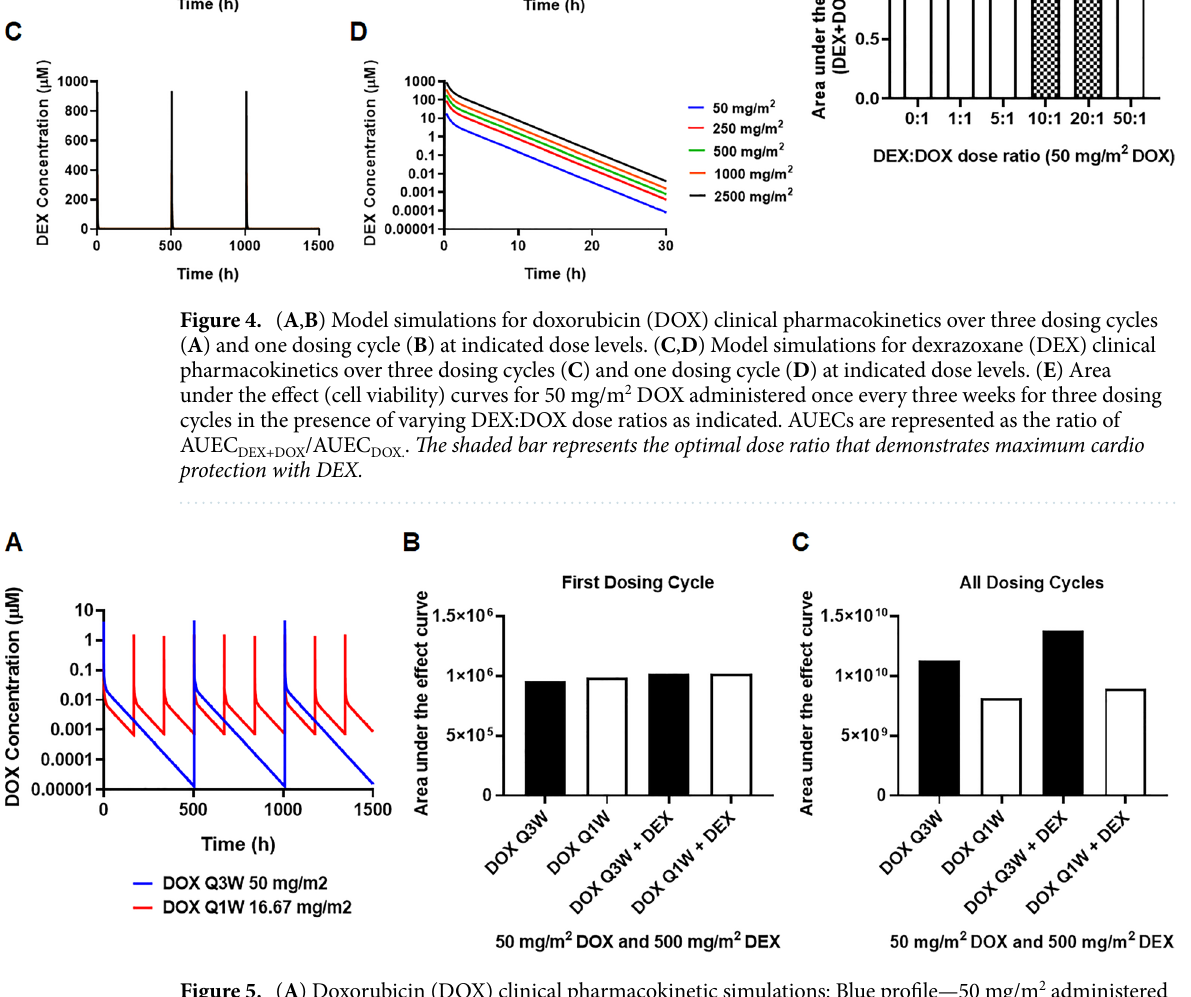
Figure 5. ( A ) Doxorubicin (DOX) clinical pharmacokinetic simulations: Blue profile—50 mg/m 2 administered every three weeks (Q3W) for three cycles, Red profile—16.67 mg/m 2 administered once every week (Q1W) as a dose-fractionated regimen. ( B ) Area under the effect (cell death) curves for doxorubicin (DOX) administered as a Q3W or Q1W regimen in the presence or absence of dexrazoxane (DEX) over three weeks (one dosing cycle) and ( C ) over nine weeks (three dosing cycles). Black solid bars represent Q3W regimens and open bars represent Q1W regimens of DOX. The Q3W DOX regimen with 10:1 DEX:DOX ratio at the indicated dose levels demonstrates maximum cardio